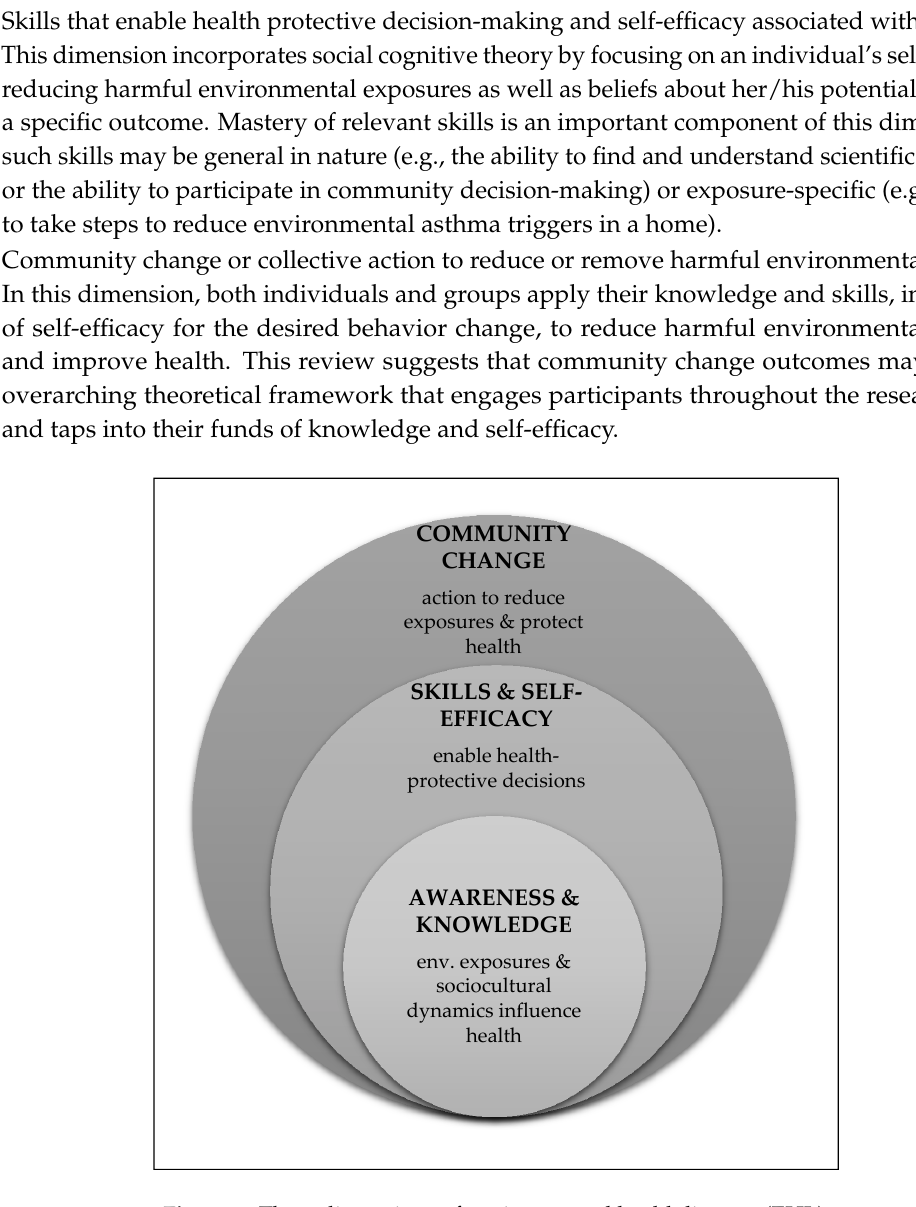
Figure 2. Three dimensions of environmental health literacy (EHL).